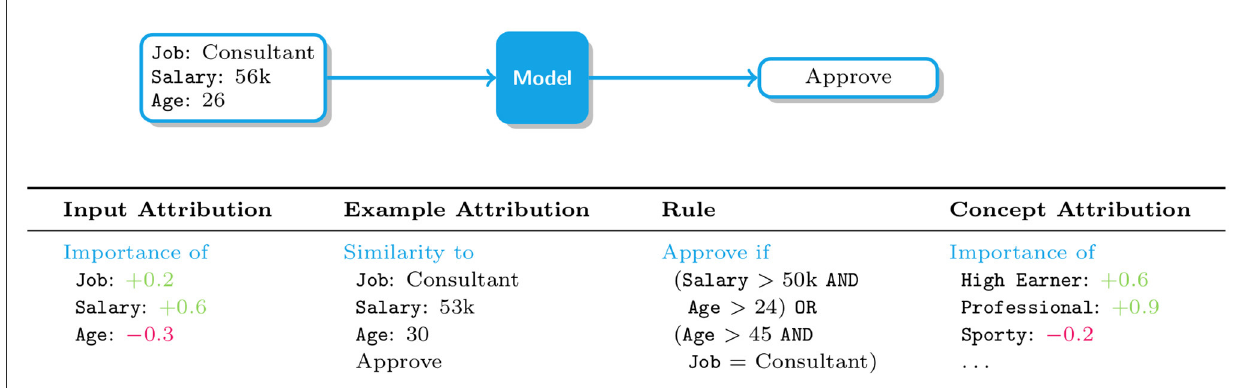
FIGURE1 Illustration of how various kinds of explanations support human understanding in the context of loan requests. From left to right: input attributions and example attributions (discussed in Section 3), rules (discussed in Section 4), and concept attributions (discussed in Section 5).